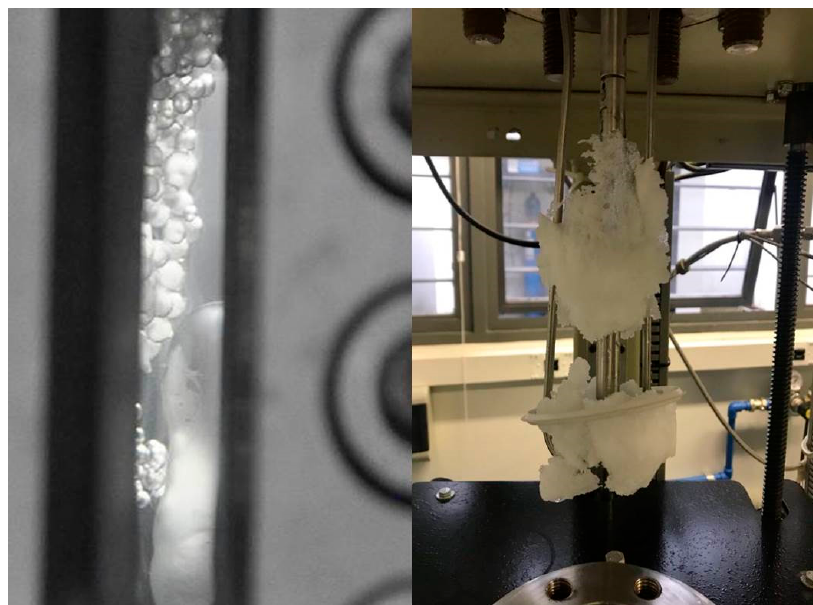
Figure 11. Images of the beginning of the formation of GH by the window and after the opening of the reactor.